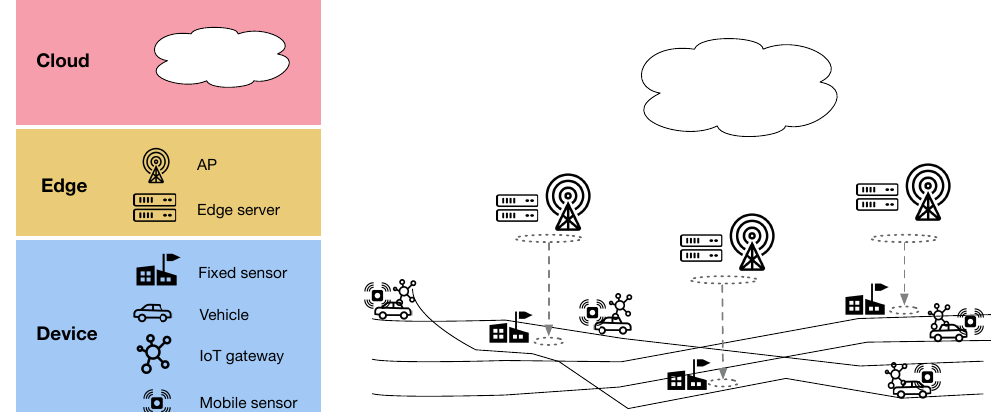
Figure 1. Overview of EDISON. The device layer comprises fixed sensors as well as mobile sensors mounted on vehicles. IoT gateways provide connectivity, store mobile sensor observations, and pro- vide local computational capabilities. The edge layer enhances the fixed sensors with connectivity and further computational capacity. Cloud provides coordination and centralized